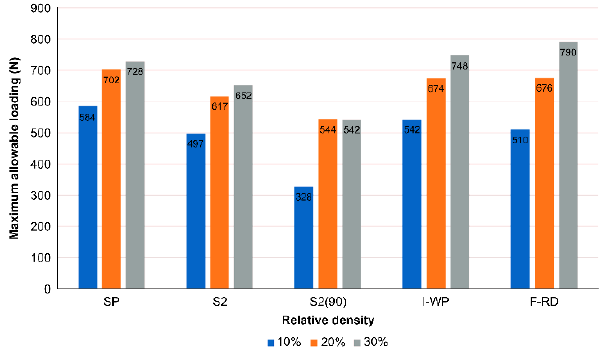
Figure 12. Maximum allowable loads of four TPMSs at different relative densities.